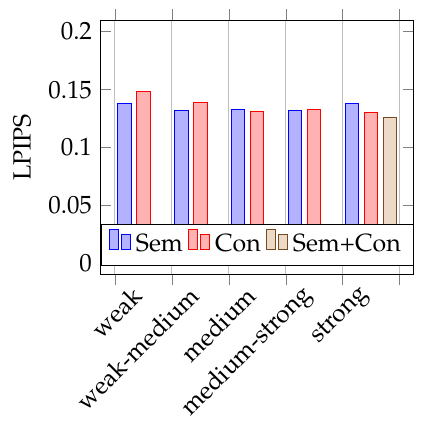
Figure 7. Mean LPIPS on synthetic